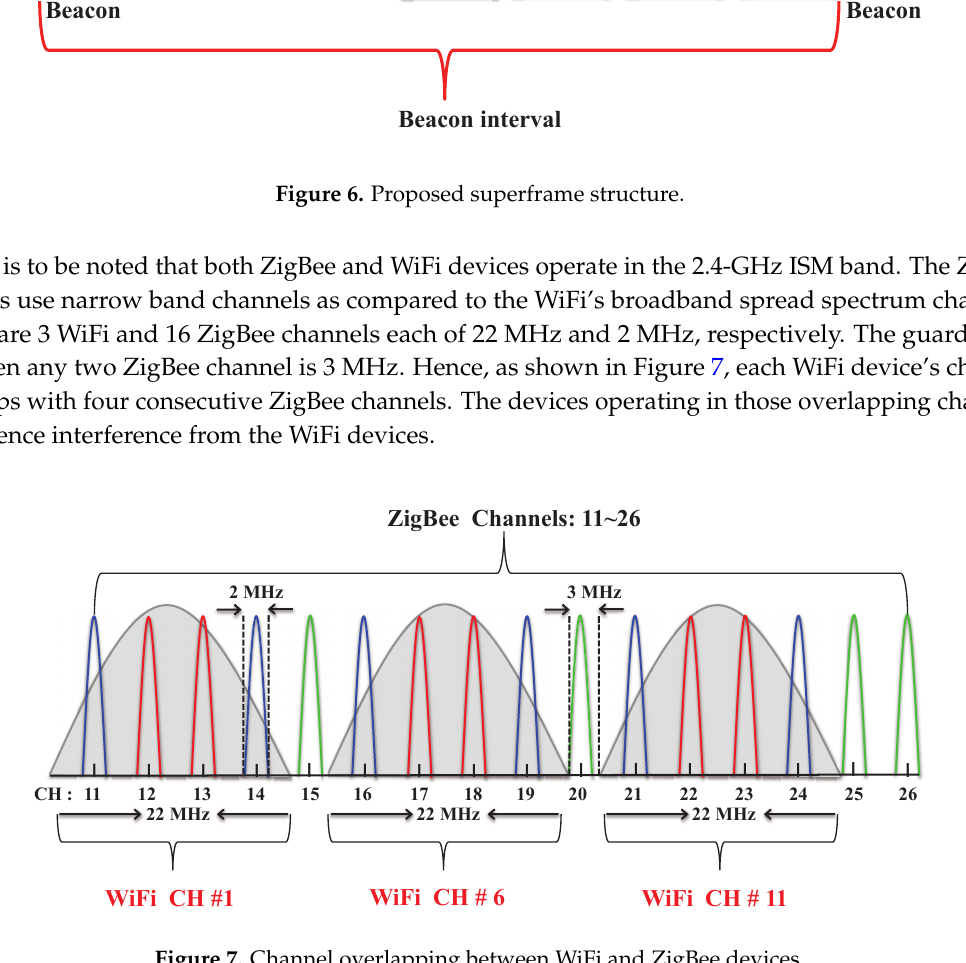
Figure 7. Channel overlapping between WiFi and ZigBee